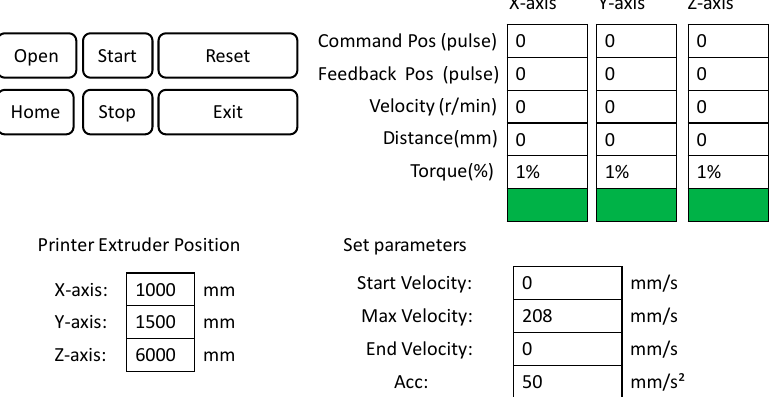
Figure 5. Control interface of the operating device.